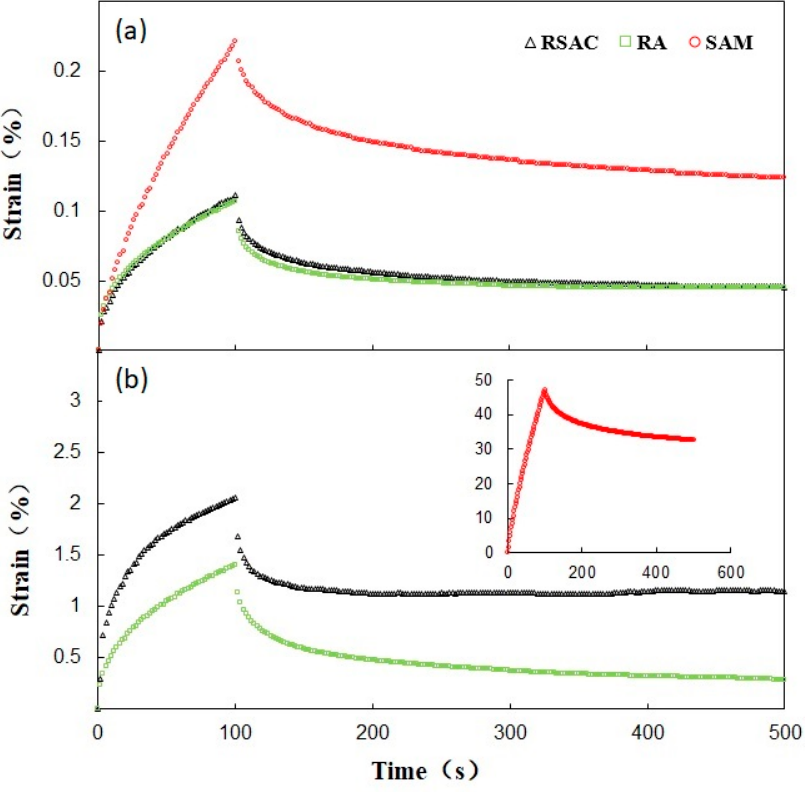
Figure 4. Creep deformation curves for modified asphalt samples ( a ) at 0 ◦ C; ( b ) at 60 ◦ C. Table 7. The creep deformation results of three modified asphalt samples at 0 ◦ C and 60 ◦ C. Item Total Deformation Permanent Deformation Recovery